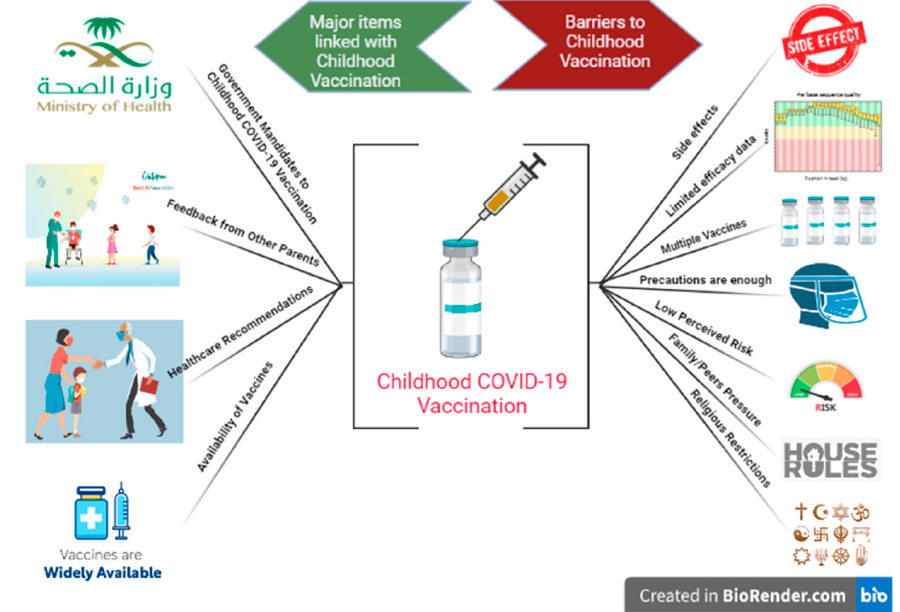
Figure 2. Themes related to the intentions and barriers of childhood COVID-19 vaccination generated by this